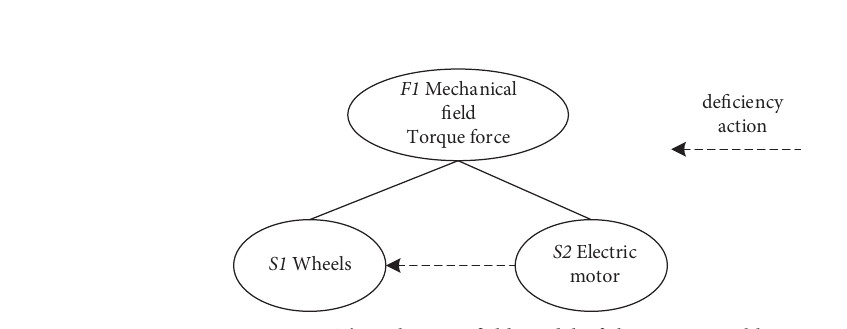
Figure 4: The layout diagram of multiwheels driving.